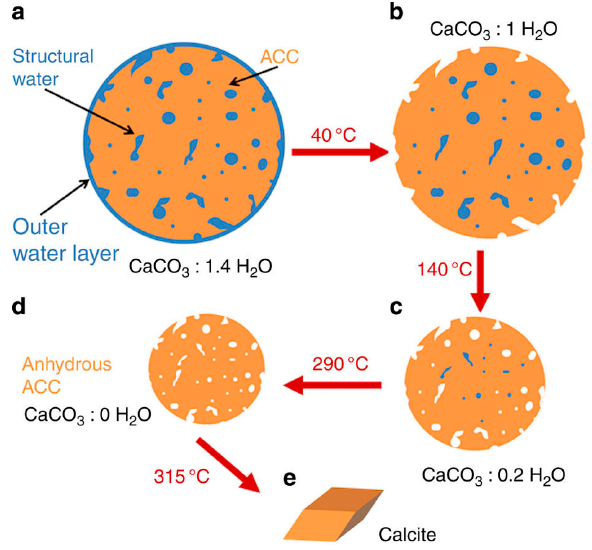
Figure 9. Schematic of stages of ACC dehydration. The solid-solid transformation is followed by water dehydration of ACC. Upon going from a to b , surface-bound water is lost, during b to c water is lost from the interior of the ACC and the ACC particle shrinks. Going from c to d , the most deeply located water is expelled, and from d to e , crystallization to calcite occurs. Reproduced with permission from Macmillan Publishers Limited in Reference